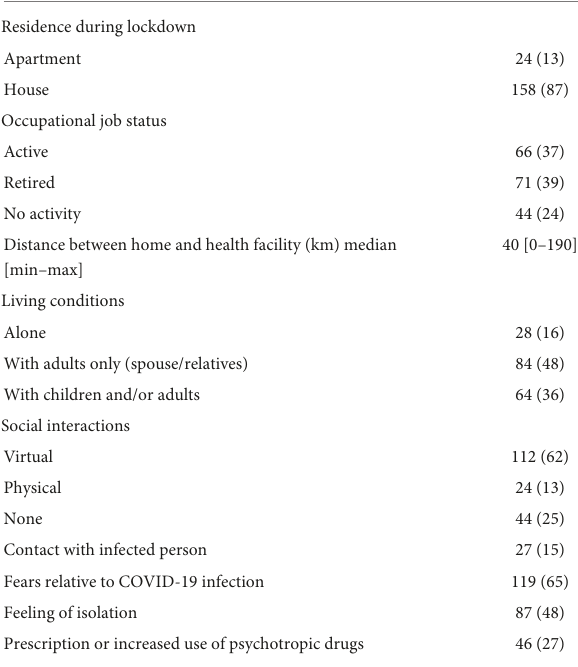
TABLE 2 The social and psychological experiences of breast cancer (BC) patients during the first coronavirus disease (COVID-19) lockdown ( N =